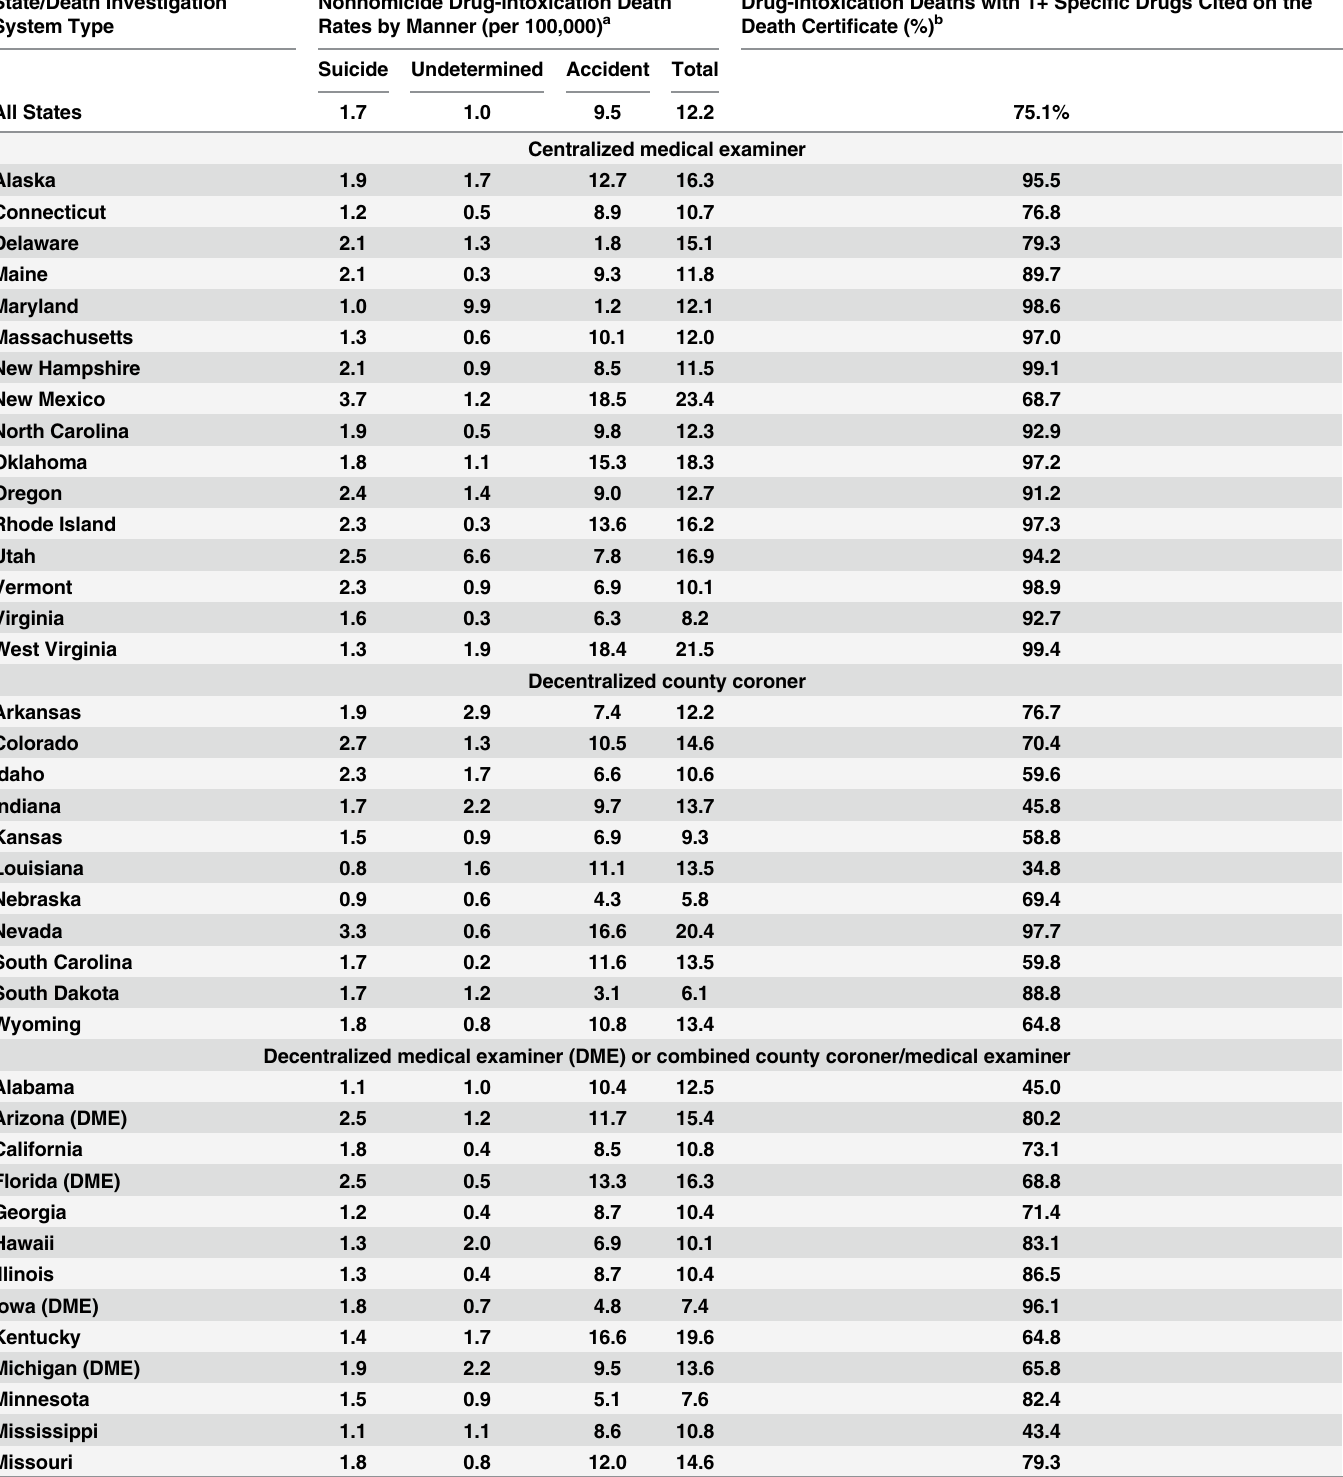
Table 1. Annualized rates for selected cause-specific manners of death and specific drug citation by state/death investigation system type: United States, 2008 –